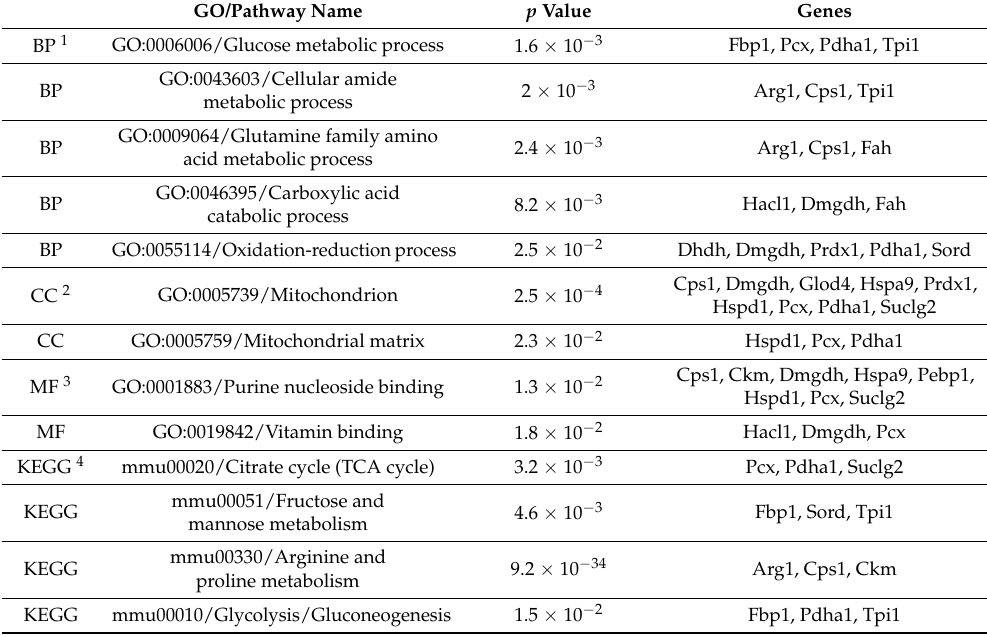
Table 2. Enrichment analysis of metabolic pathways and biological function of differentially expressed